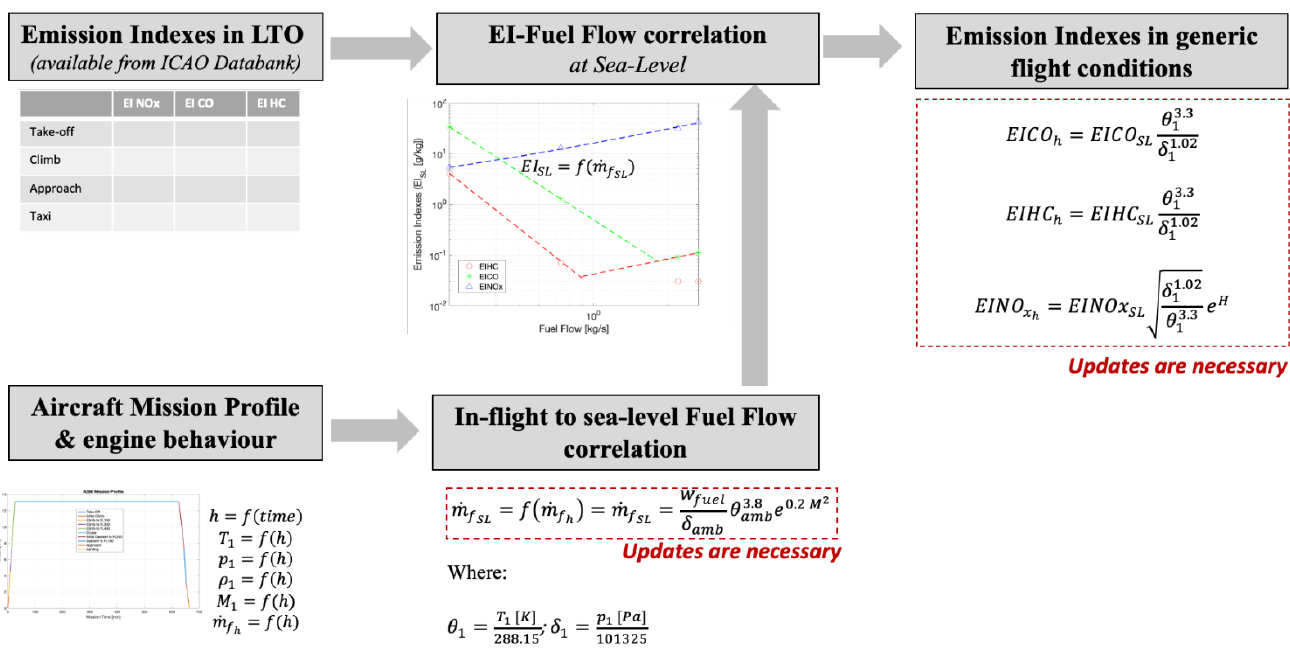
Figure 1. Original fuel flow method by Boeing and improvements to cope with supersonic case studies and sustainable aviation fuels.